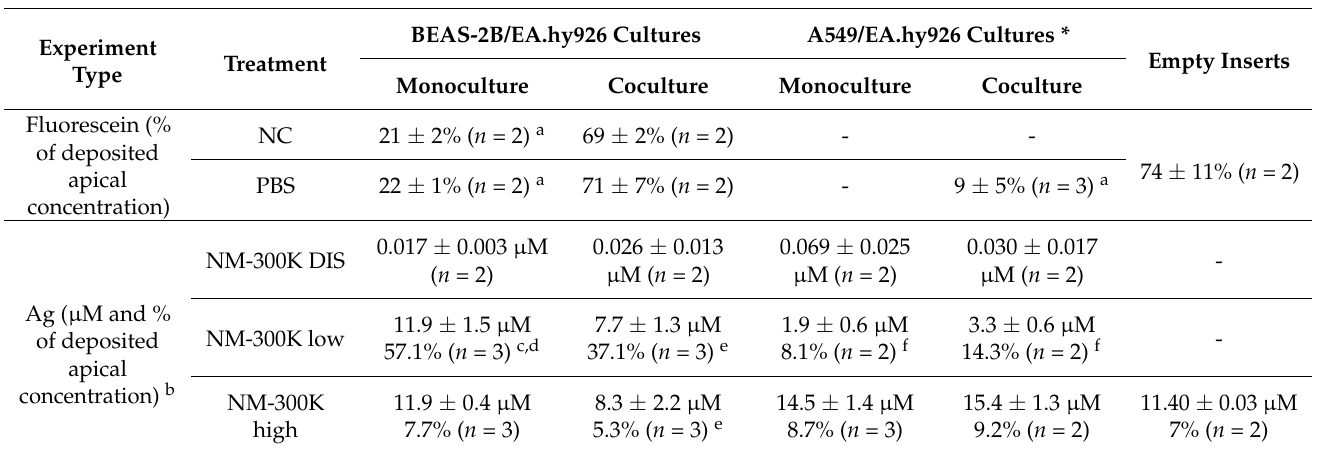
Table 3. Comparison of the barrier integrity of mono- and cocultures of BEAS-2B/EA.hy926 and A549/EA.hy926 cells, by measurement of fluorescein sodium salt and Ag permeation. Results are presented as mean permeation with SD of n = 2–3 independent experiments with single or duplicate inserts. Permeation is presented as the basolateral concentration ( µ M) and as the basolateral concentration relative to the deposited apical concentration (%). Results for A549/EA.hy926 cultures are based on our previous publication [39]. NC: negative control. PBS: phosphate-buffered saline, NM-300K DIS: dispersant control, NM-300K low: nominal 1 µ g/cm 2 , NM-300K high: nominal 10 µ g/cm 2